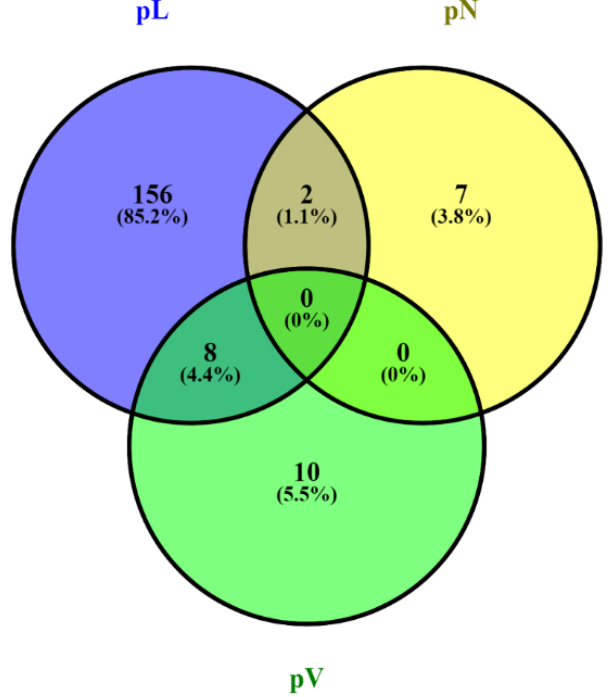
Figure 2. MALDI-IMS derived peptide values discriminative between the prognostic subgroups of lymphatic vessel invasion (pL), nodal metastasis (pN) and angioinvasion (pV) and their overlap. Discriminative peptide values: 156 peptides are unique to distinguish between tumors with lymphatic vessel invasion (pL+) and absence of lymphatic vessel invasion (pL − ), seven peptides for nodal metastasis (pN+) and no nodal metastasis (pN − ) and ten peptides for angioinvasion (pV+) and absence of angioinvasion (pV − ).